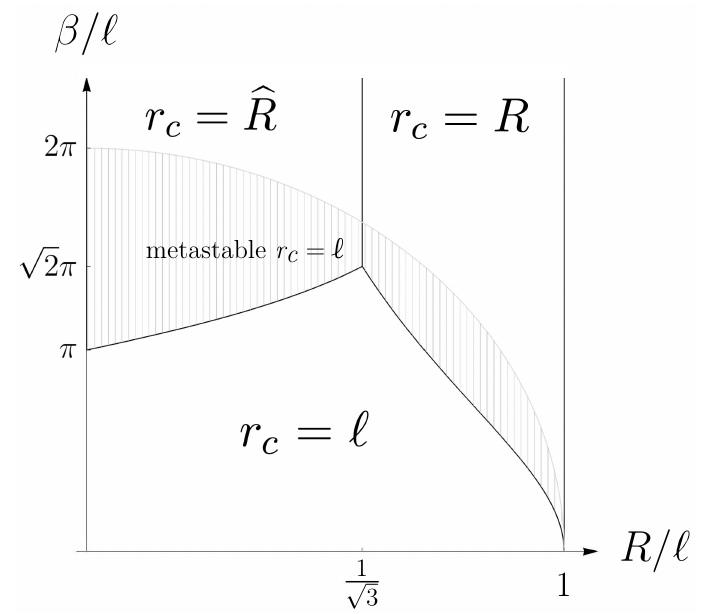
Figure 9. Phase diagram for c-horizon configurations, with boundary size R and inverse temper- ature β . The upper boundary of the metastable r c = ‘ region corresponds to the blueshifted dS temperature. As shown in figure 6, below that temperature — marked by C — the r c = ‘ endpoint is no longer a local minimum of the action (even excluding negative mass